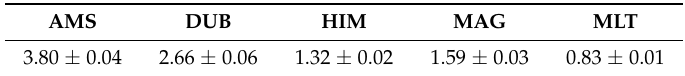
Table 6. Mean total concentrations (mg/kg) OCPs in selected malt